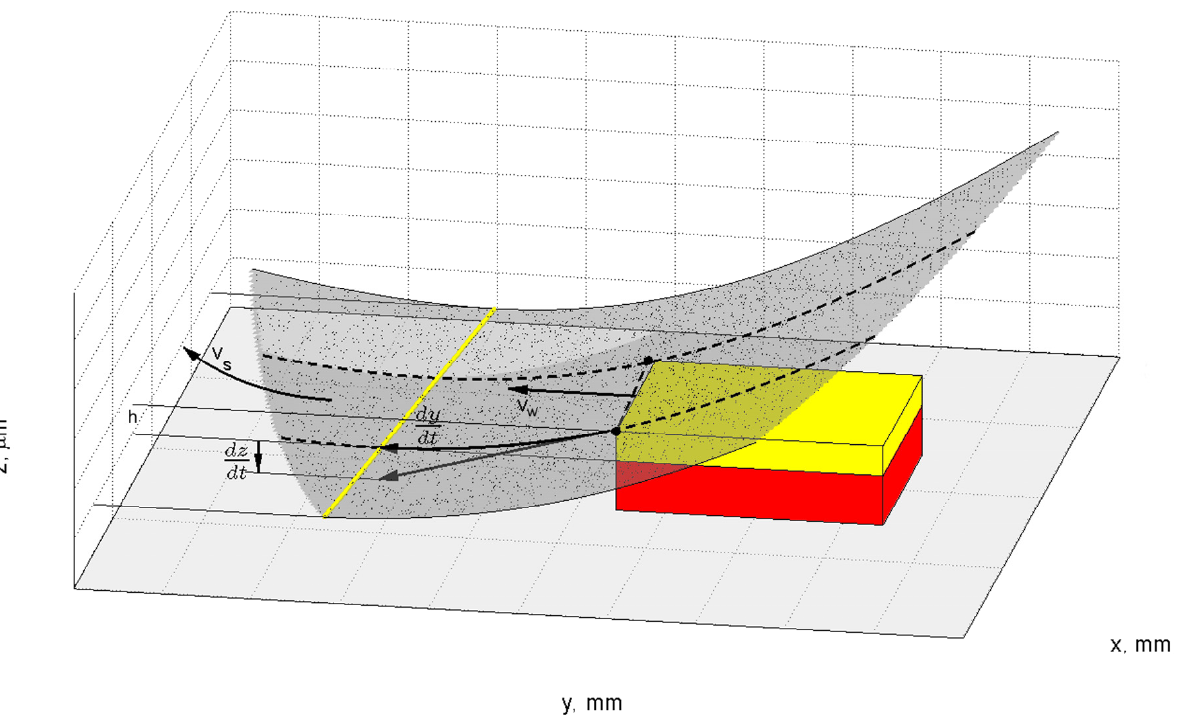
Figure 13. Graphical interpretation of the material removal speed 𝑣 ℎ =